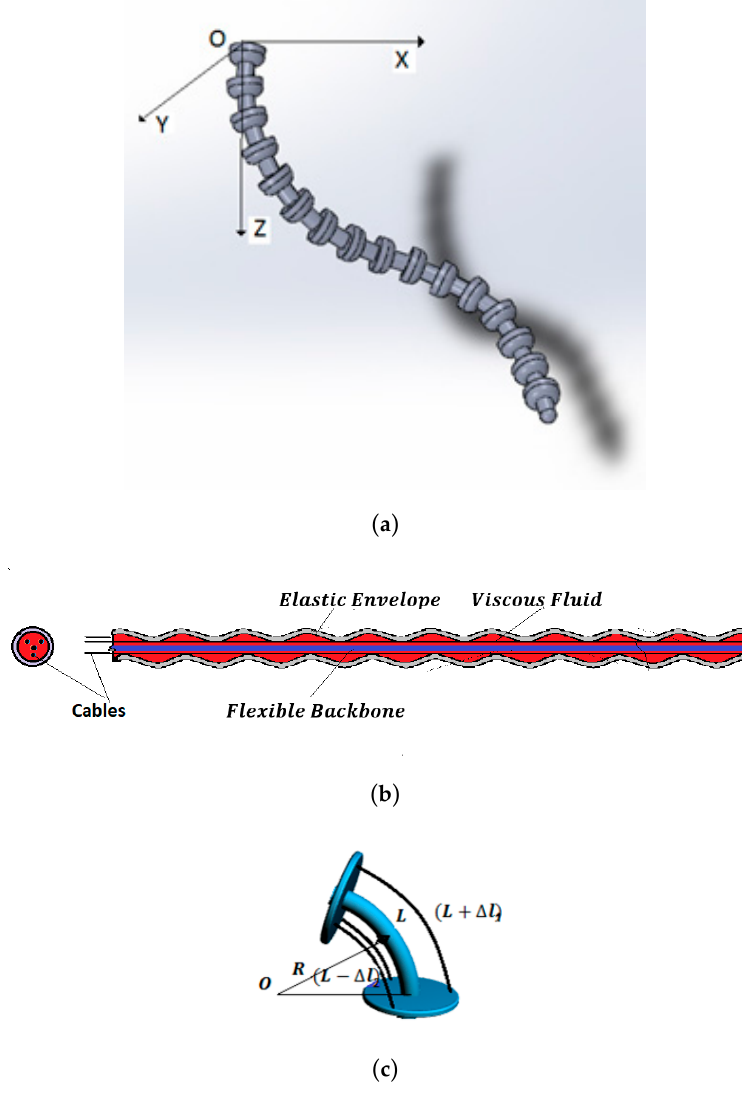
Figure 1. ( a ) 3D hyper-redundant robotic arm. ( b ) 3D FOM curvature sensor. ( c ) Measurement technique.